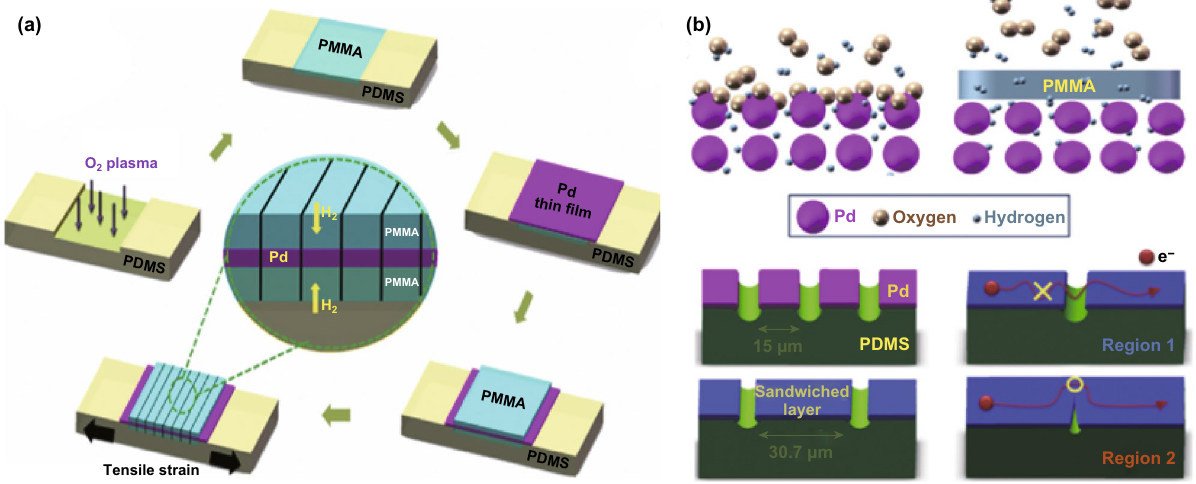
Fig. 9 a Schematic diagram of the fabrication of nanogap sensors using PMMA/Pd/PMMA trilayer films on a PDMS substrate. b Schematic diagrams indicating the origins of the difference between the H 2 detection limits of the Pd nanogap and the PMMA/Pd/PMMA hybrid nanogap sensors. Reproduced with permission [110]. Copyright 2014,